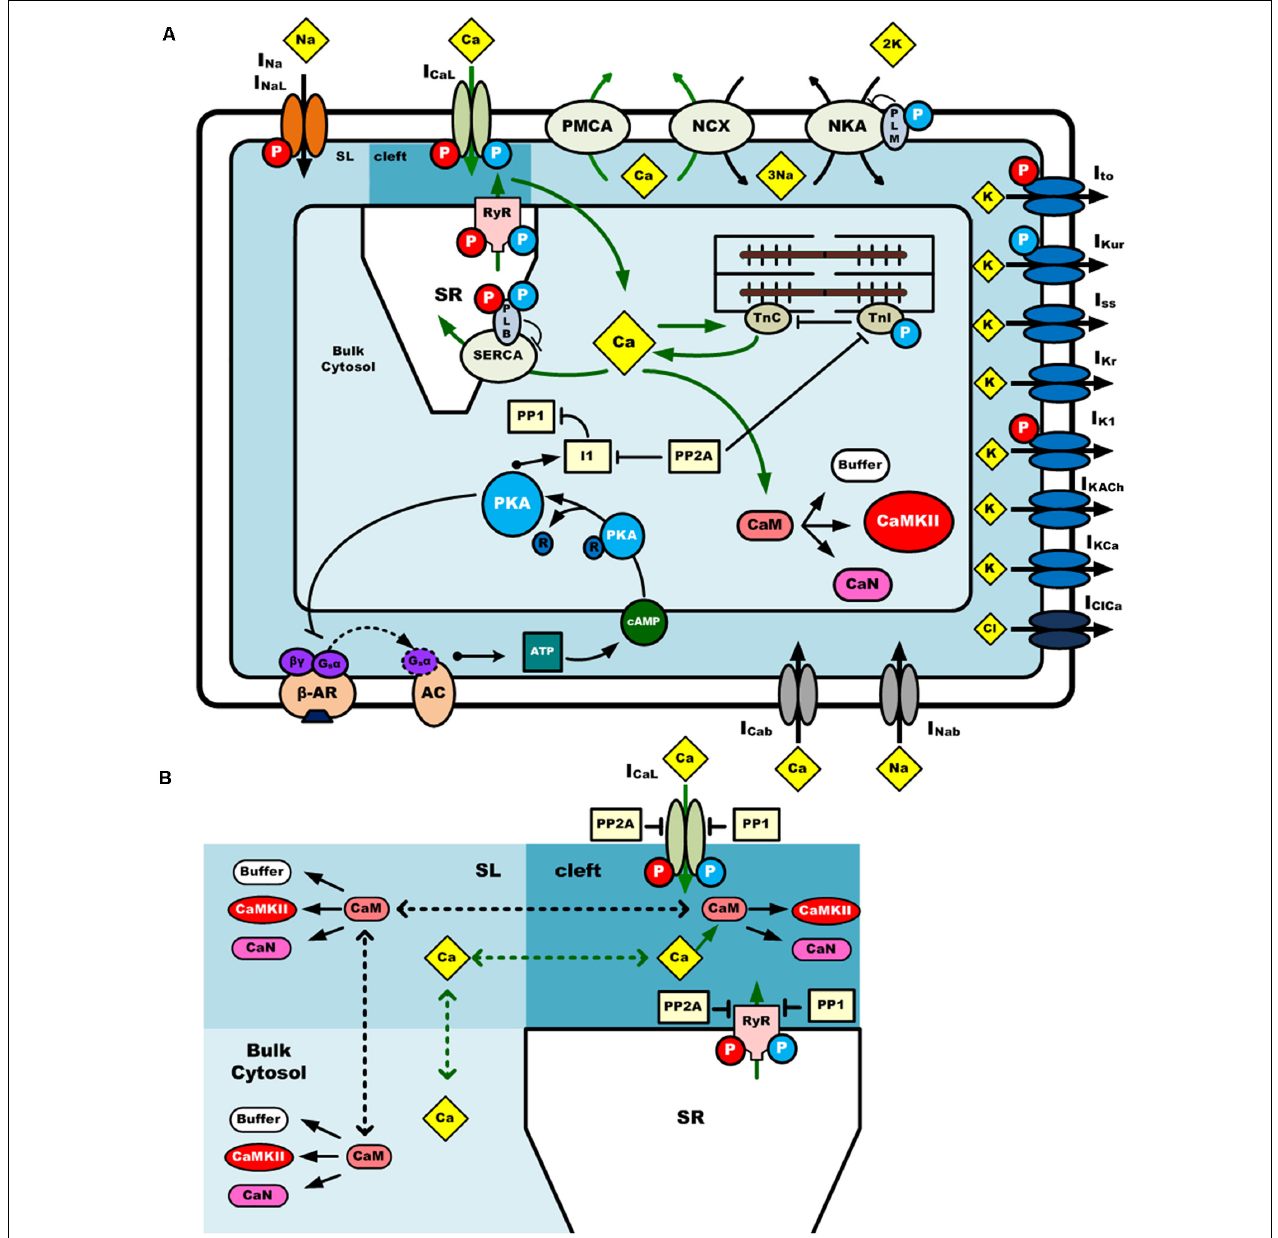
FIGURE 1 | A schematic diagram of the computational model of a mouse atrial myocyte. (A) Ionic channel currents, fluxes, signaling pathways and physical compartments of the mouse atrial model. (B) Diffusion of Ca 2 + and CaM in three compartments. CaMKII is activated by Ca 2 + -CaM binding in the dyadic cleft, sub-sarcolemma area (SL), and bulk cytosol. Phosphatases 1 and phosphatases 2A oppose phosphorylation by either kinase. Ca 2 + and CaM can diffuse across these three regions at different diffusion coefficients. The blue and red circle with “P” in it indicates the phosphorylation of the target by PKA or CaMKII, respectively. I Na , fast Na + current; I NaL , late Na + current; I CaL (or LTCC), L-type Ca 2 + current; I to , transient outward K + current; I Kur , ultra-rapidly activating delayed rectifier K + current; I Kr , rapid delayed rectifier K + current; I ss , non-inactivating steady-state voltage-activated K + current; I K1 , time-independent inwardly rectifying K + current; I KACh , acetylcholine-activated K + current; I KCa , small conductance Ca 2 + -activated K + current; I Nab , background Na + current; I Cab , background Ca 2 + current; I Kb , background K + current; I Clb , background Cl - current; I ClCa , Ca 2 + -activated Cl - current; PMCA, plasma membrane Ca 2 + pump; NKA, Na + /K + -ATPase; NCX, Na + /Ca 2 + exchanger.